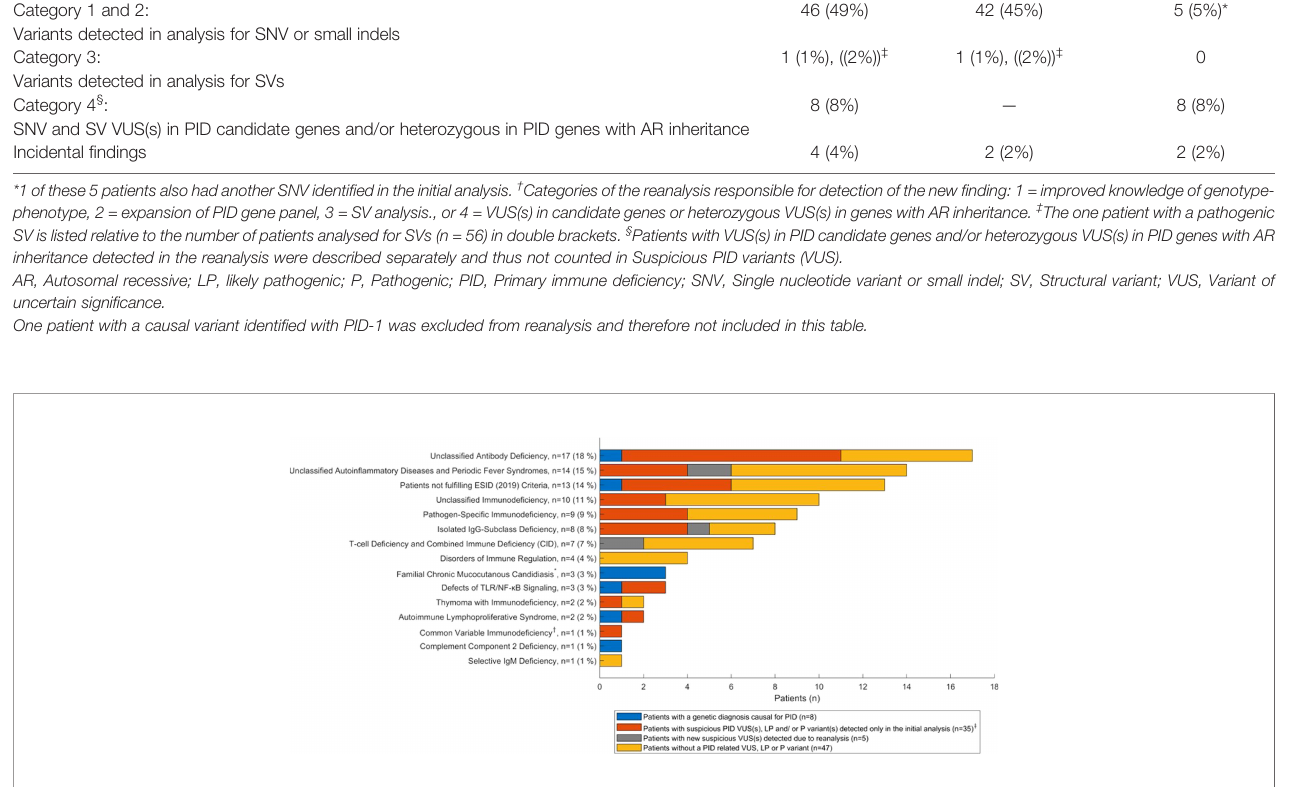
FIGURE 2 | Distribution of the genetic results (PID-1 and PID-2 combined) across ESID (2019) subgroups (n = 95 patients). *The Familial Chronic Mucocutanous Candidiasis subgroup includes the one patient excluded from reanalysis. † One child with CVID was included, as the child is part of a family including a parent and sibling with antibody de fi ciency. ‡ Includes eight patients with suspicious PID variants (LP/P) and 28 patients with suspicious PID variants (VUS), of which one is included in the fi ve patients with new suspicious VUS(s) detected due to reanalysis, since this patient also had a suspicious PID VUS detected in the reanalysis. VUS, variant of uncertain signi fi cance; LP, likely pathogenic; P,